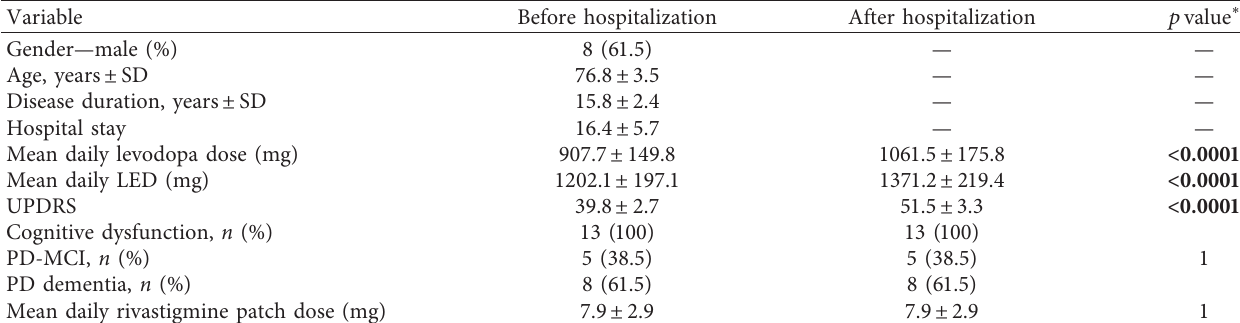
Table 1: Characteristics of advanced PD patients with clinical or surgical